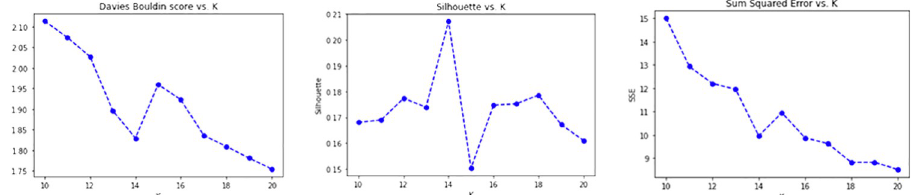
Fig 18. Validation results obtained for